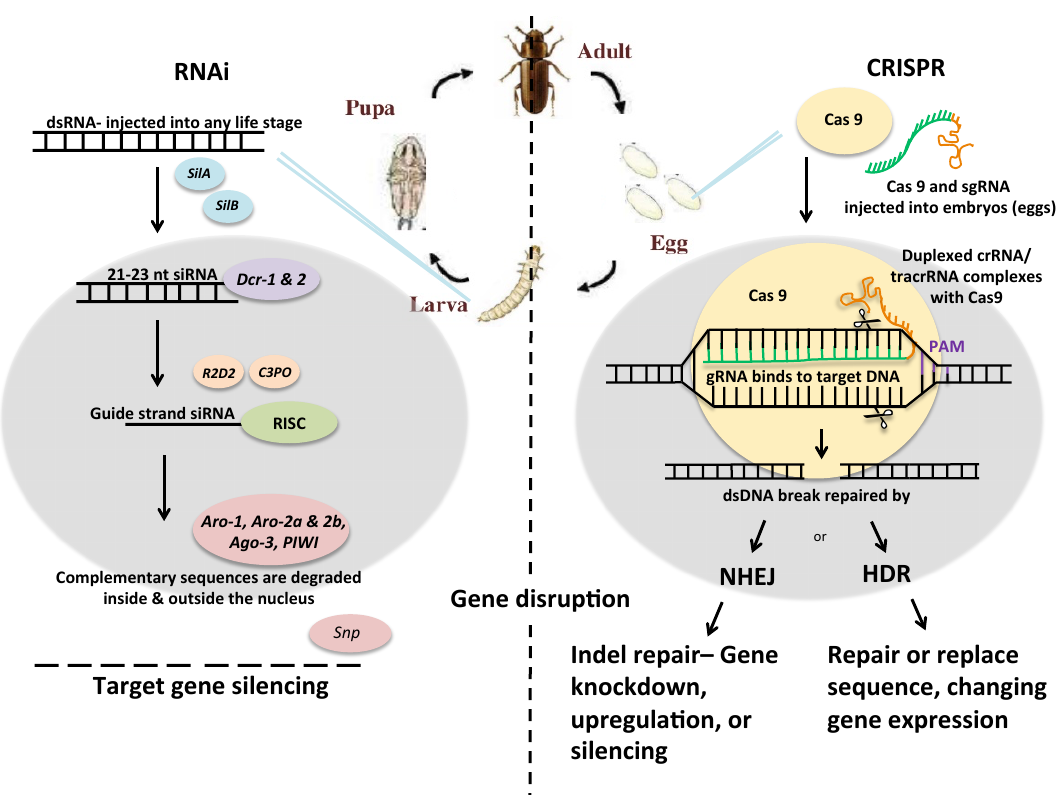
Figure 1. Schematic of RNA interference (RNAi) ( a ) and CRISPR-Cas ( b ) technology in Tribolium castanem . The grey oval represents the cell nucleus. On the RNAi side ( a ), dsRNA can be injected into any life stage. The double stranded RNA (dsRNA) is incorporated into the cell with SilA and SilB (SID-1 orthologs). Dcr-1 and 2 ( Dicer ) cleave the dsRNA into 21 nt pieces, R2D2 and C3PO help load the RNAs into the silencing complex. Aro-1, 2a, 2b, 3, and PIWI endonucleases degrade the complementary RNA inside the nucleus while Snip ( SNP ) exonuclease degrades the complementary RNA outside of the nucleus. On the CRISPR side ( b ), Cas9 and single guide RNA (sgRNA) is injected into eggs. Duplexed crRNA/tracrRNA complexes with Cas9 endonuclease, resulting in a precise dsDNA break. The break is repaired by either non-homologous end joining (NHEJ) or homology-directed repair (HDR), which results in gene knockdown, upregulation, silencing, or changes in gene